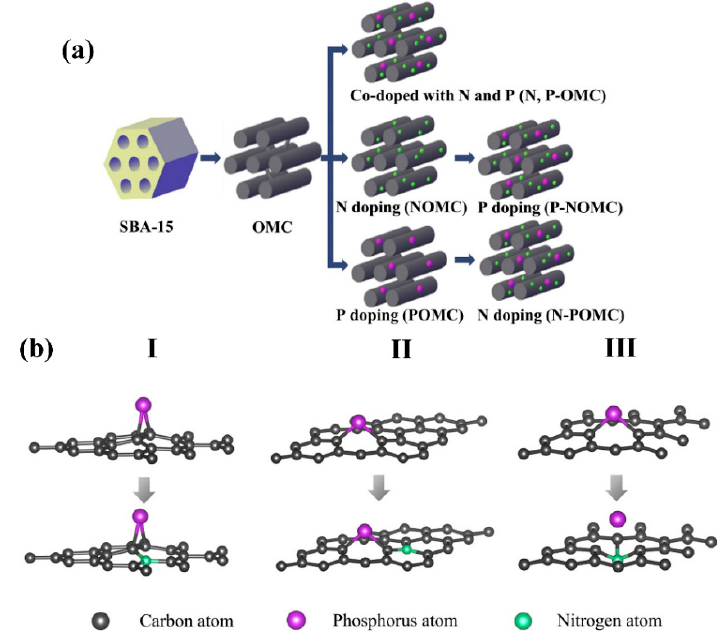
Figure 5. ( a ) Scheme of the synthesis of the N, P dual-doped OMCs; ( b ) scheme of the orientation effect of the first doped P and then doped N: (I) outside, (II) inside, (III) self-sacrifice type. Adapted from [88], with permission from the International Journal of Hydrogen Energy , 2018. Table 2. Summary of nitrogen-doped graphene synthesized via the hydrothermal method as electrocatalyst for ORR.